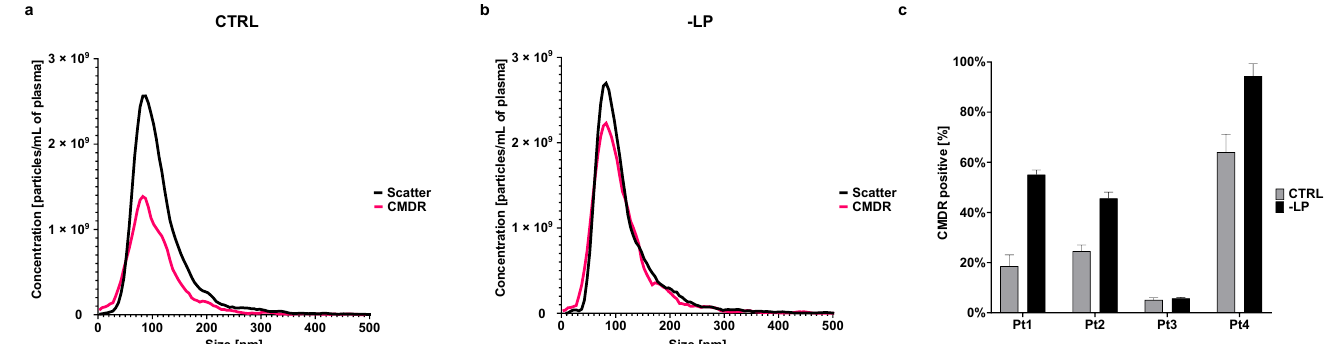
Figure 9. Lipoprotein removal from plasma EVs. ( a ) Distribution of particles in the scatter and fluorescent mode (640 nm) for plasma EVs of a representative patient during NTA measurement (CTRL). ( b ) Distribution of particles in the scatter and fluorescent mode (640 nm) for plasma EVs of a representative patient during NTA measurement after lipoprotein removal (-LP). ( c ) The percent of CMDR positive particles in comparison to all particles visible in the scatter mode of plasma EVs before and after lipoprotein removal. Graphs ( a , b ) present the mean from four replicates. Graph ( c ) presents the mean and SD from three (Pt1) to six (Pt2–4)